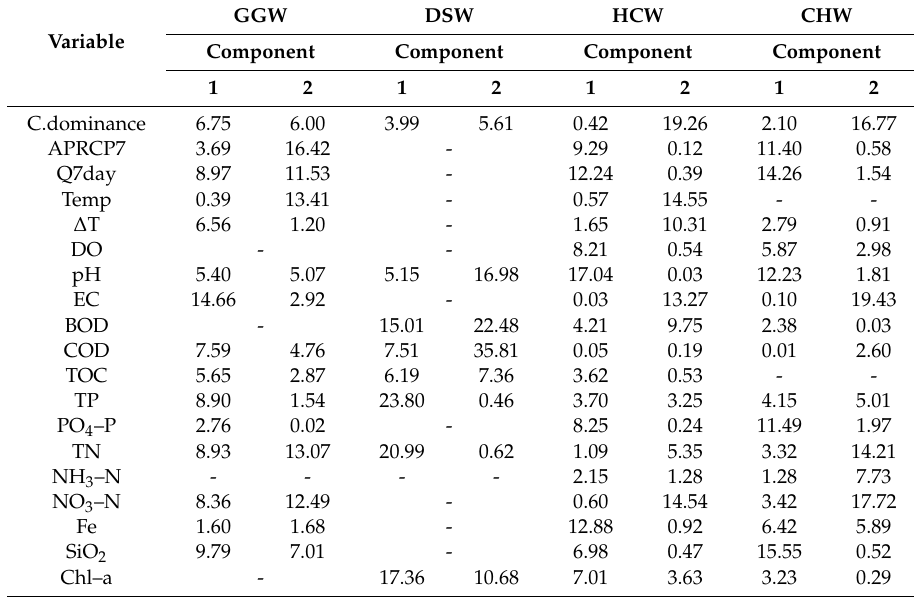
Table 4. Contributions of variables to principal components; Gangjeong Goryeong weir (GGW), Dalseong weir (DSW), Hapcheon Changnyeong weir (HCW), and Changnyeong Haman weir (CHW). Note: see the main text for definitions of abbreviated variables.